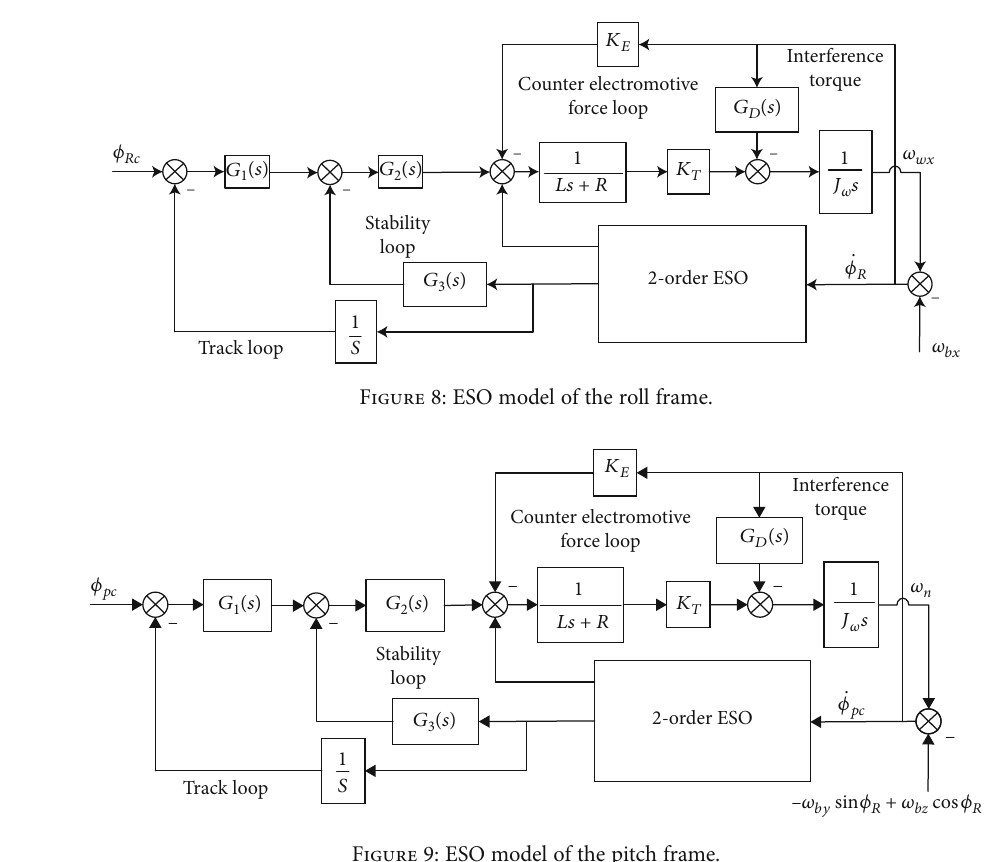
Figure 9: ESO model of the pitch frame.